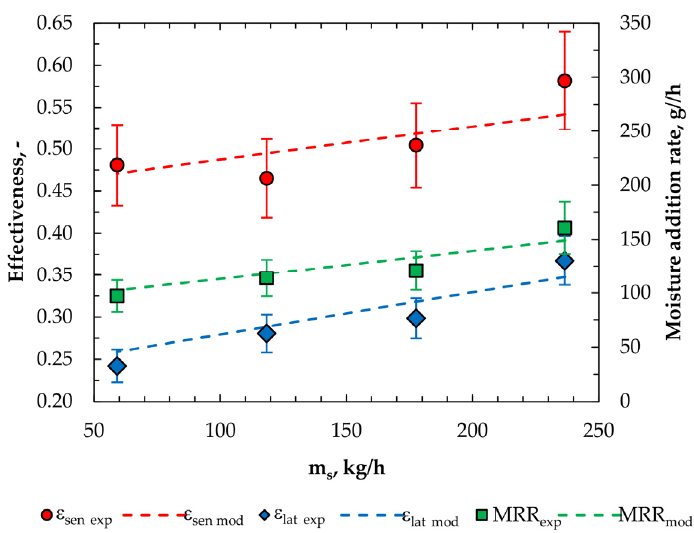
Figure 6. Comparison of experimental and modeling performance indices of the module for solution flow rate (m a = 81 kg/h, X = 31.2%).